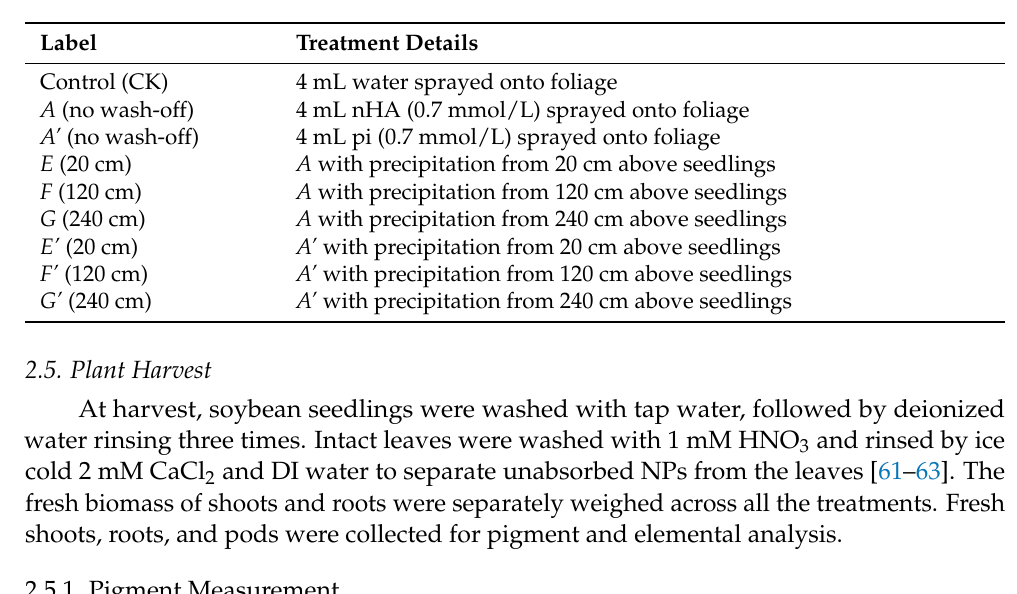
Figure 1. Schematic illustrations of simulated precipitation ( A ) and wash-off test ( B ). Table 2. Details of each treatment in the wash-off